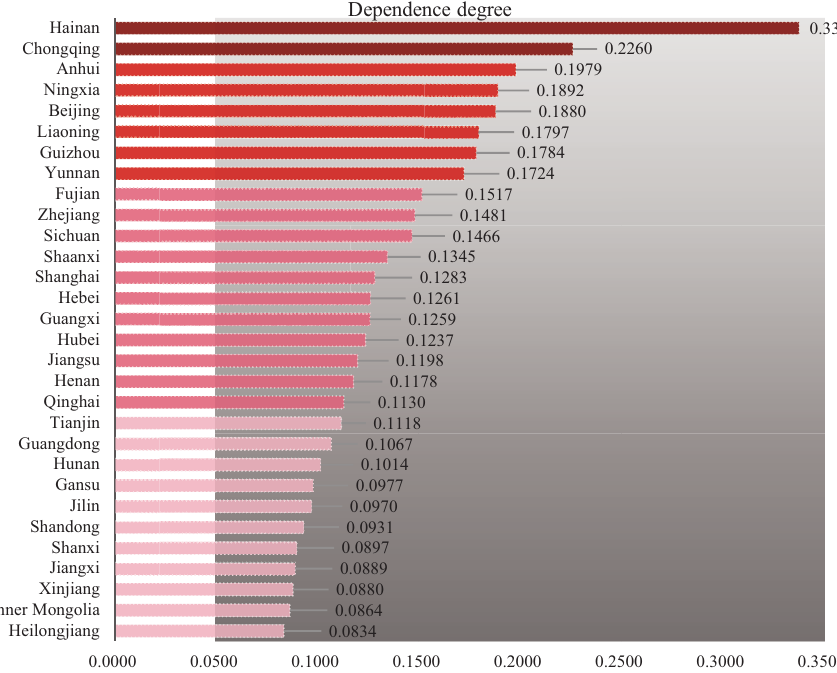
Figure 11. The average dependence degree of the economy on the real estate industry in